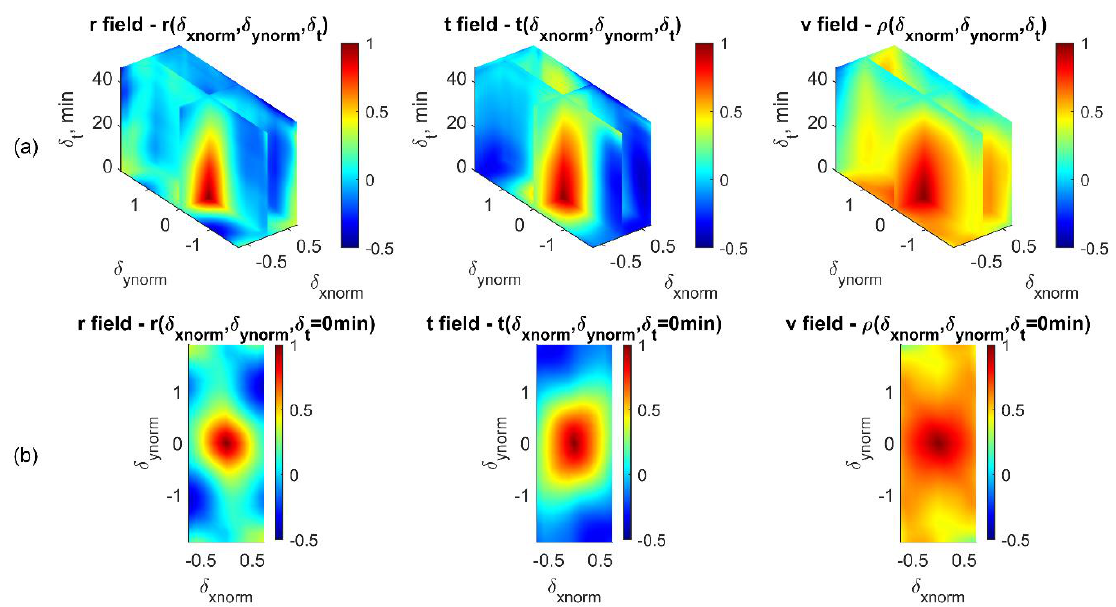
Figure 17. Spatio-temporal empirical correlation structures of 3D-T data ensembles under cylindri- cal coordinates. ( a ) Smooth representation of correlation structures for r , t , and v displacement fields (left to right). ( b ) Spatial correlation maps for r , t , and v displacement fields when 𝛿 𝑡 = 0 min (i.e., floor of ( a